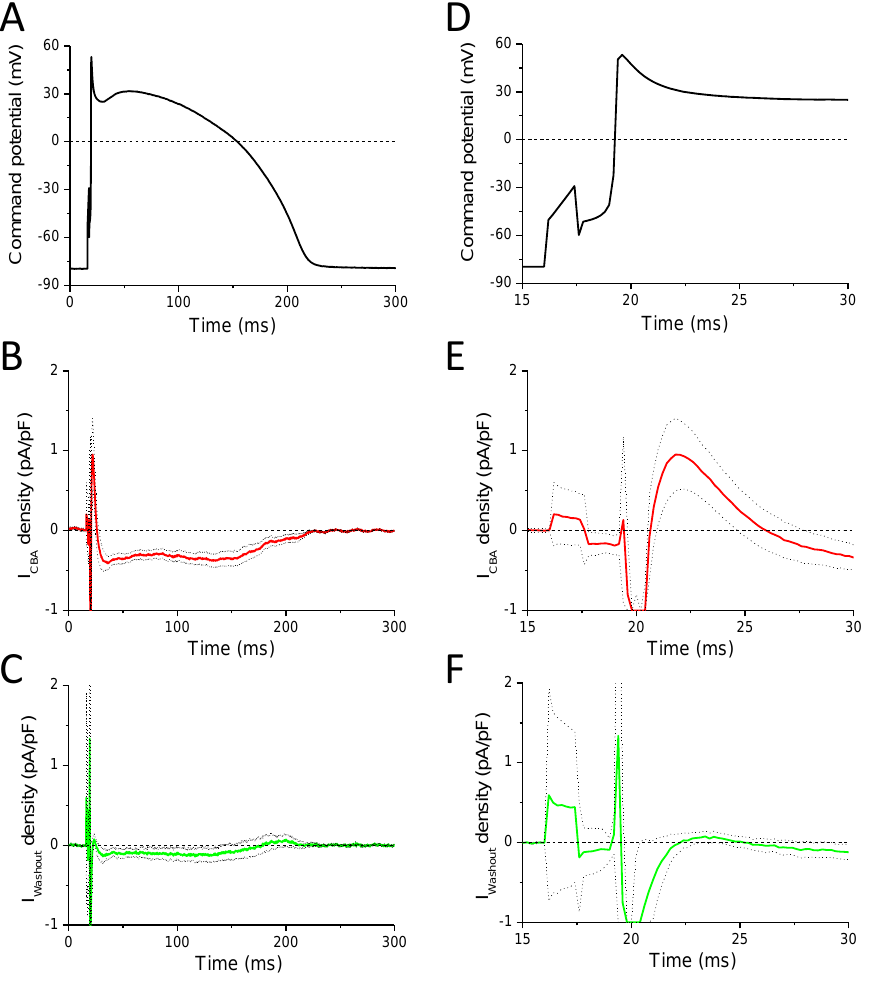
Figure 5. Effects of CBA in action potential voltage-clamp recordings using canonic APs. ( A ) Command potential used for stimulation. ( B ) Average (solid red line) ± SEM (dotted lines) of CBA-sensitive current density obtained in five cells isolated from three animals. ( C ) Average (solid green line) ± SEM (dotted lines) of current densities measured in four out of the initial five cells after washout of CBA. ( D ) The initial part of panel A is shown enlarged. ( E ) The initial part of panel B is shown enlarged. ( F ) The initial part of panel C is shown